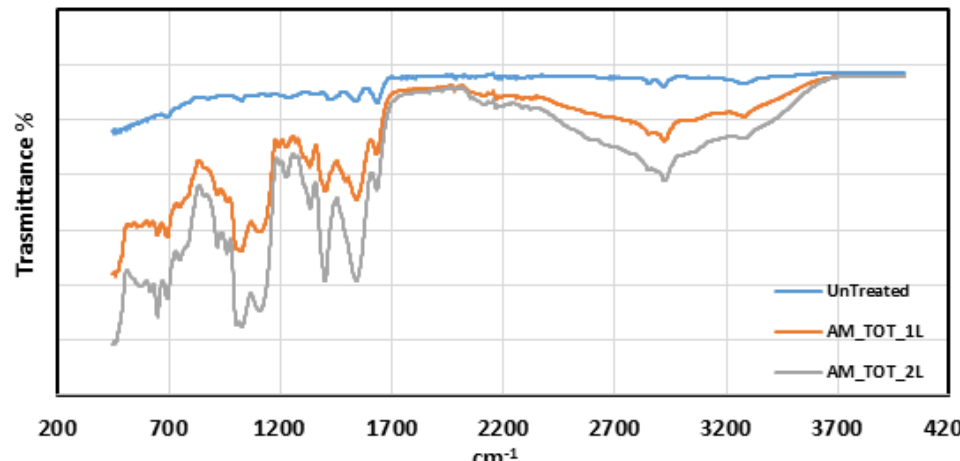
Figure 4. Fourier transform infrared (FTIR) on untreated and (3-Aminopropyl)trimetoxysilane (AM) treated PA12-CR substrates .